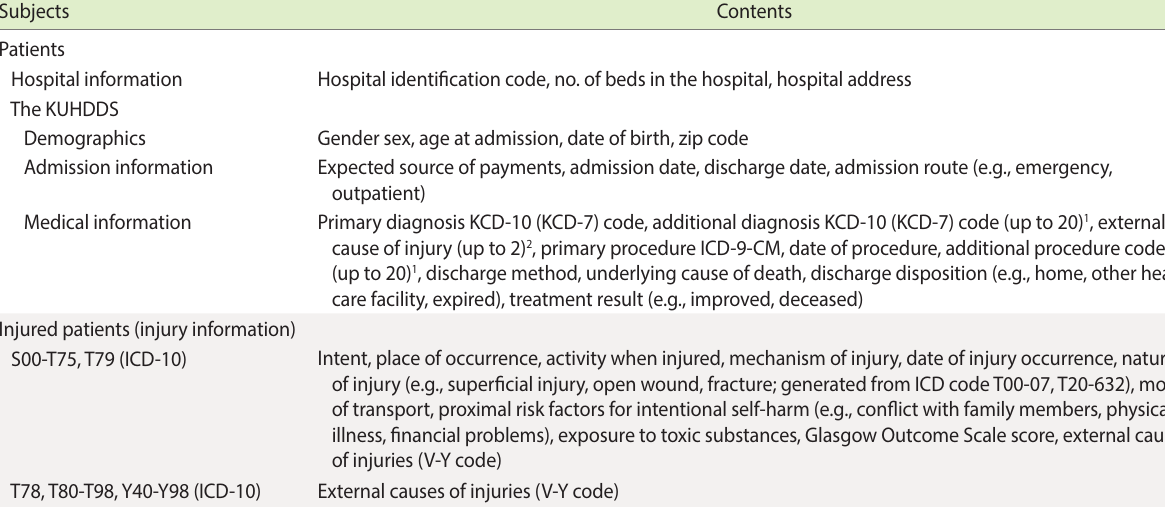
Table 3. The KNHDIS data variables elements (as of June 2020)